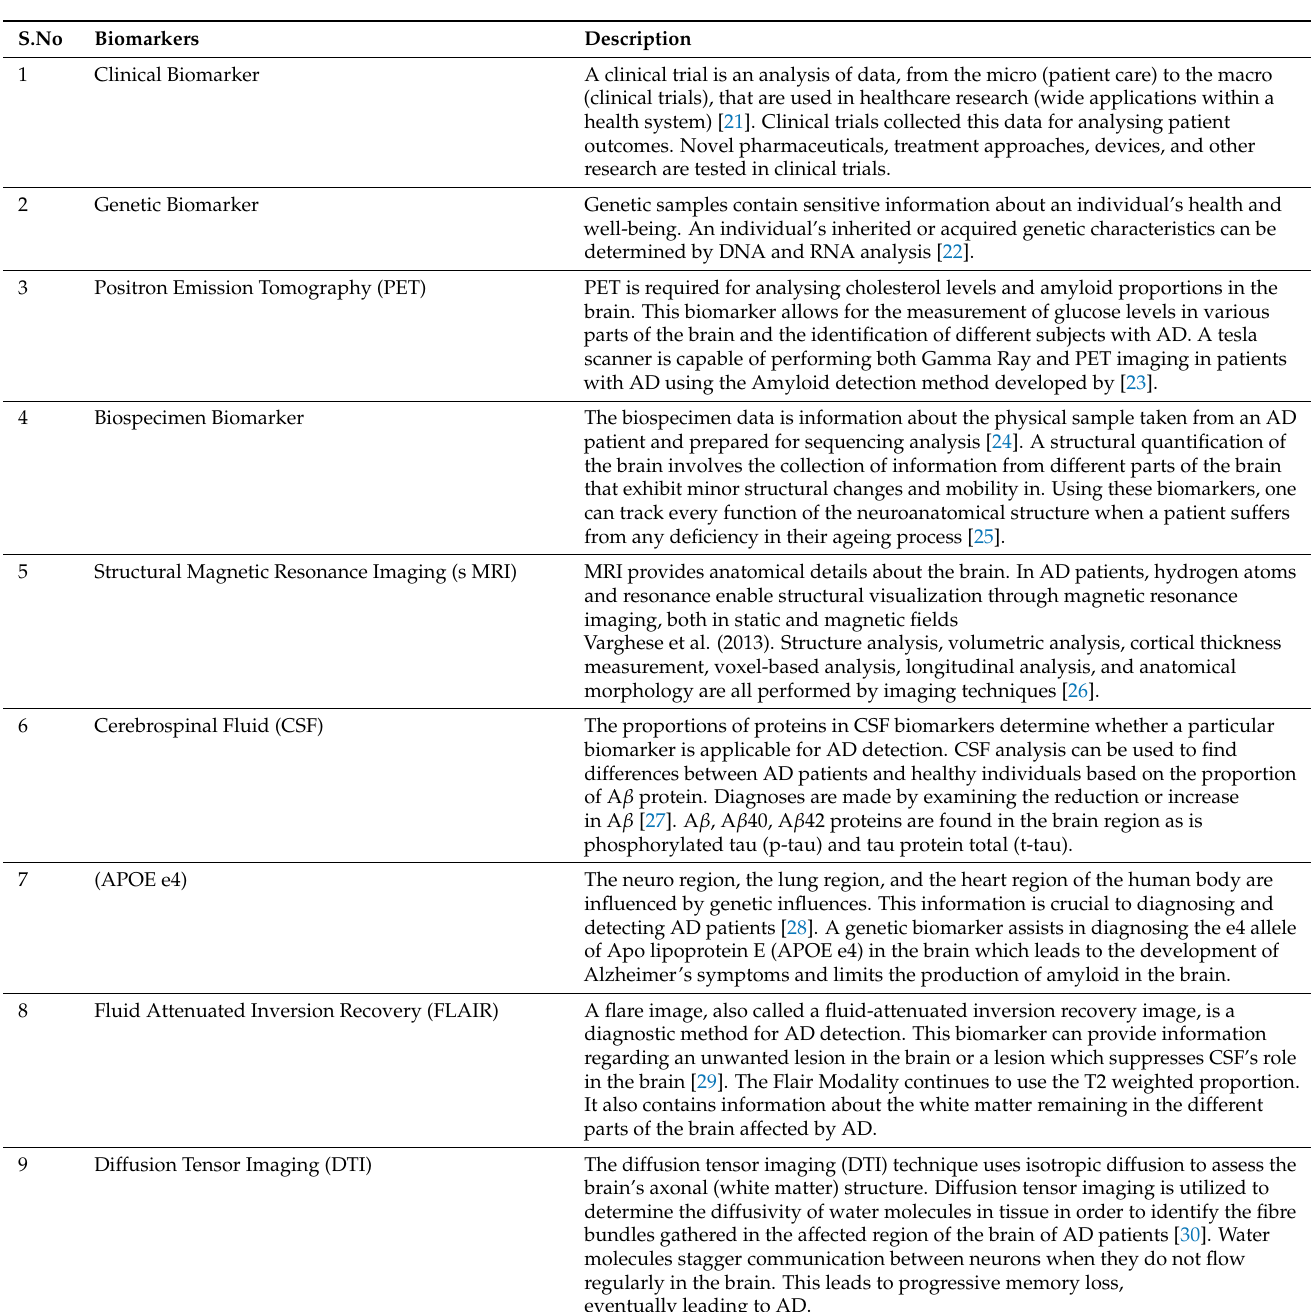
Table 2. Description of Different